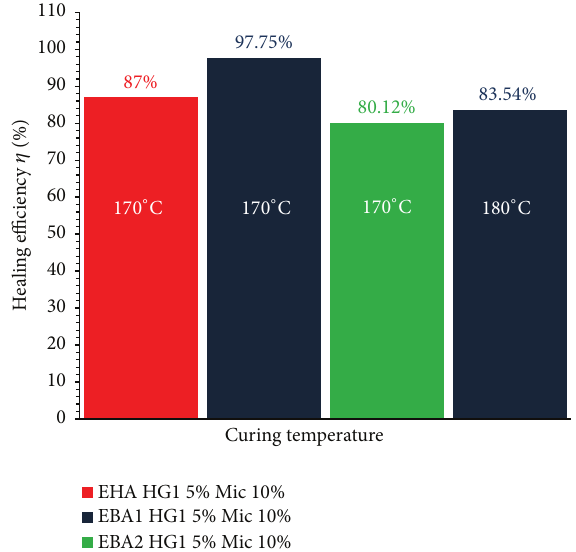
Figure 8: Comparison of healing efficiency for self-healing systems with different epoxy matrices (EHA, EBA1, and EBA2), at the different curing